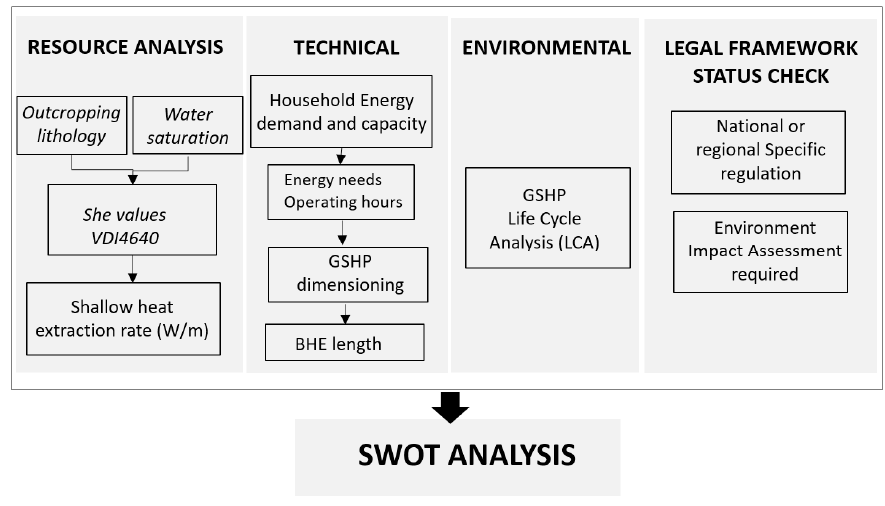
Figure 1. The methodology is applied to measure the success or failure of the GSHP technology in a specific place.